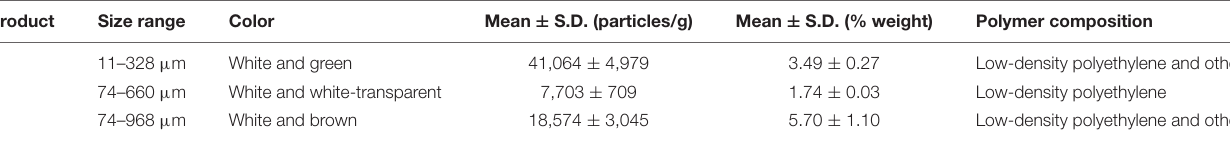
TABLE 2 | Microbeads characterized in three top-sale personal care and cosmetic products in Macao.